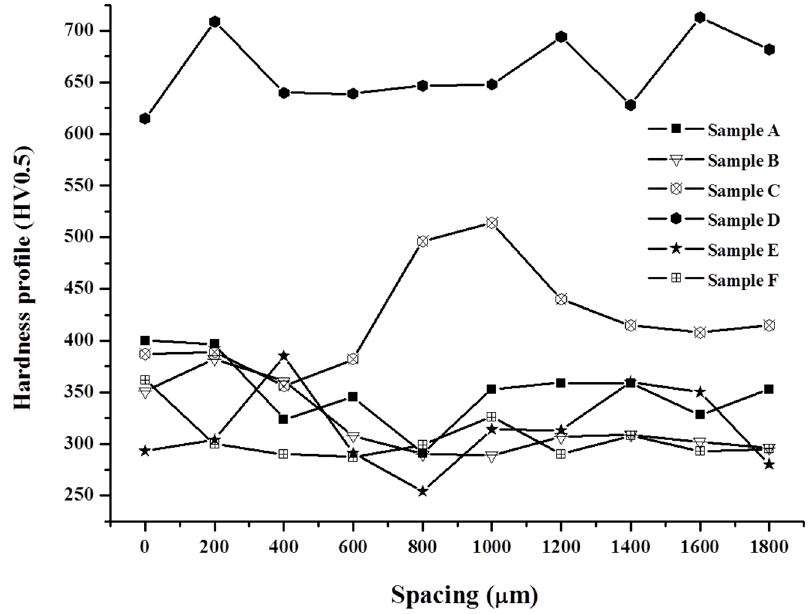
Figure 9. Hardness profile of the heat-treated samples.